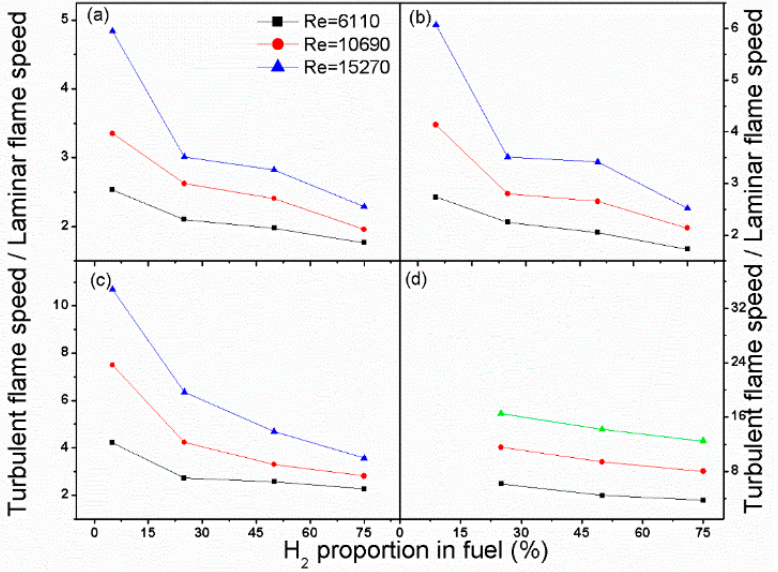
Figure 14. The ratio of turbulent flame velocity to laminar flame speed of the same syngas with different nitrogen dilution rates under different hydrogen proportions in fuel and exit Reynolds numbers: ( a ) 0%; ( b ) 10%; ( c ) 30%; ( d ) 50% nitrogen dilution volumetric